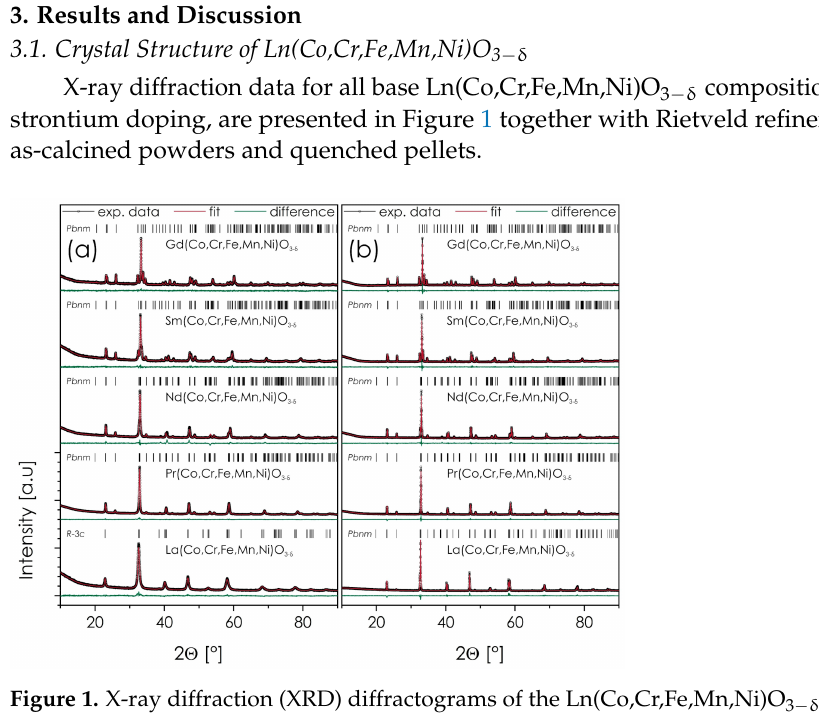
Figure 1. X-ray diffraction (XRD) diffractograms of the Ln(Co,Cr,Fe,Mn,Ni)O 3 − δ (Ln = La, Pr, Gd, Nd, Sm) materials: ( a ) as-calcined powders; ( b ) pellets quenched after sintering at 1000 ◦ C for 20